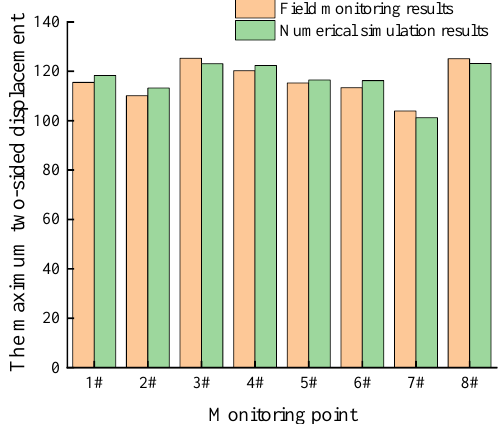
Figure 18. Numerical simulation results versus the field monitoring results of the maximum two- sided displacement.